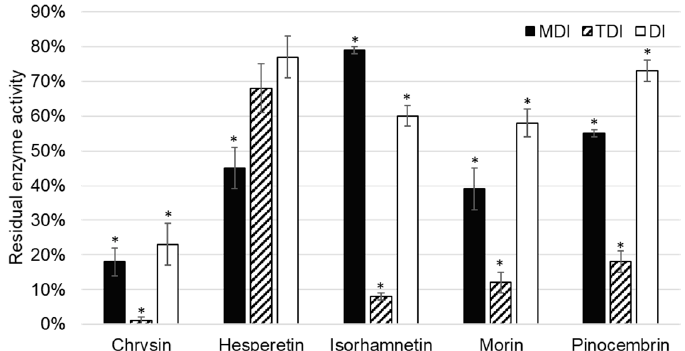
Figure 3. Residual CYP1A2 enzyme activity after incubation with 1 µ M flavonoid in the experiments for the determination of metabolism dependent inhibition (MDI), time dependent inhibition (TDI), and direct inhibition (DI). * denotes that observed inhibition is statistically significant ( p < 0.05) when compared to the control (without addition of flavonoid).